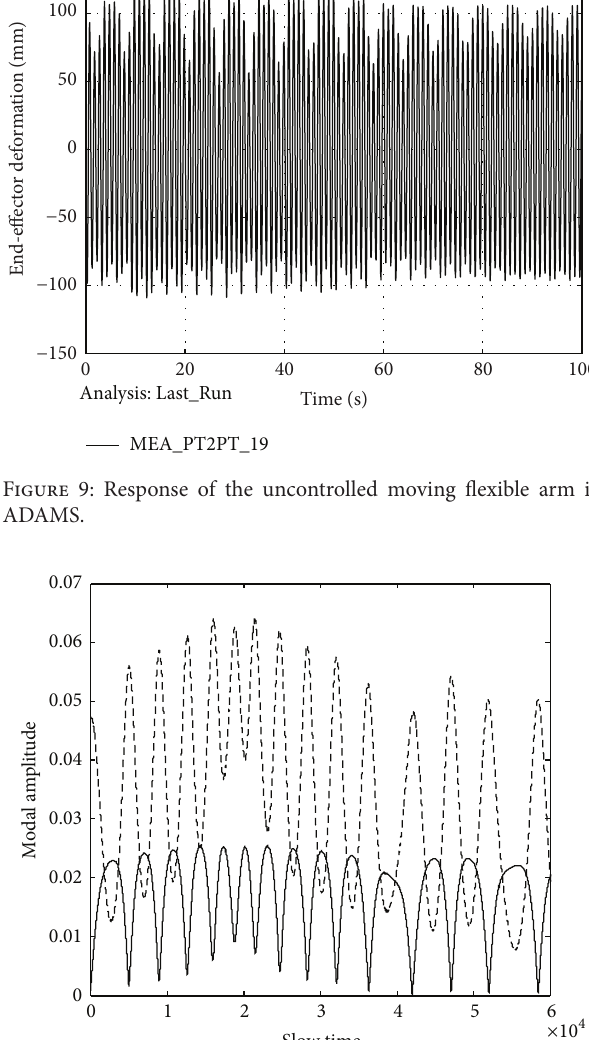
Figure 8: Response of the uncontrolled moving flexible arm.